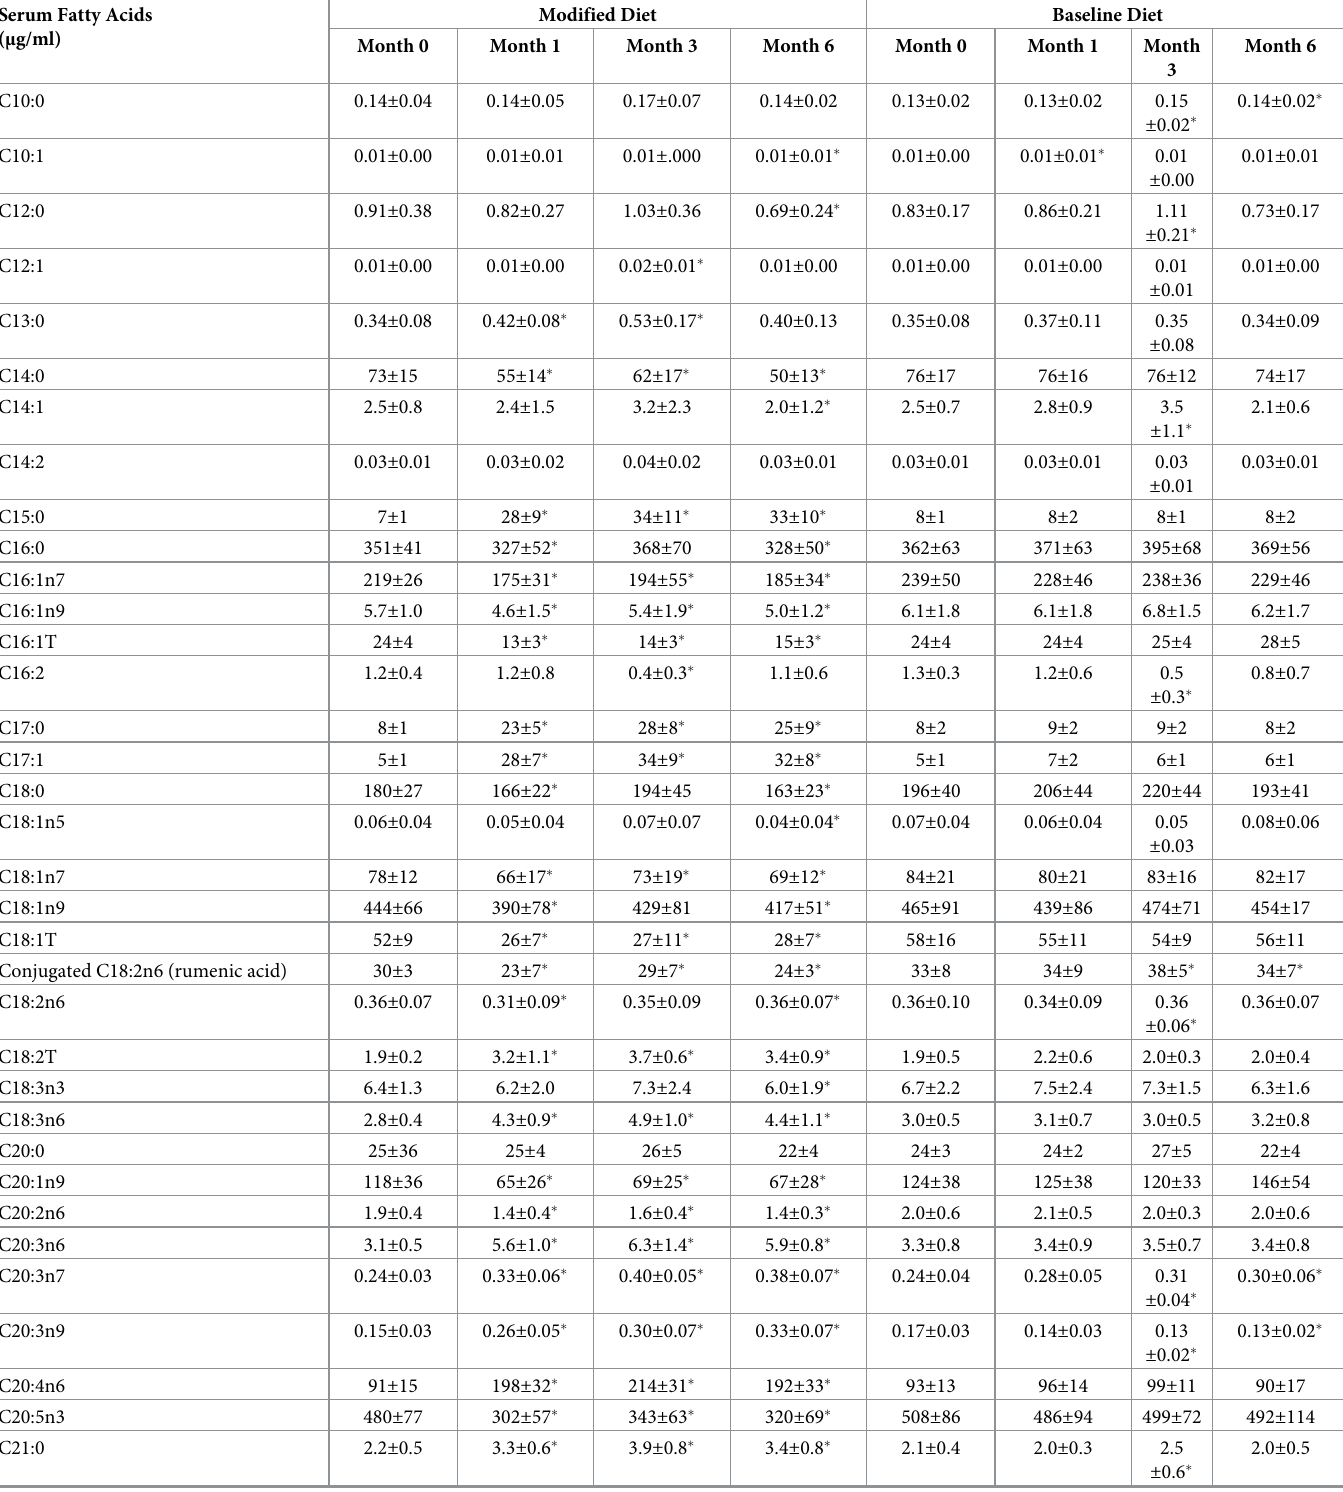
Table 6. Comparisons of serum total fatty acid values in bottlenose dolphins ( Tursiops truncatus ) fed a modified versus baseline diet. Serum Fatty Acids ( μ